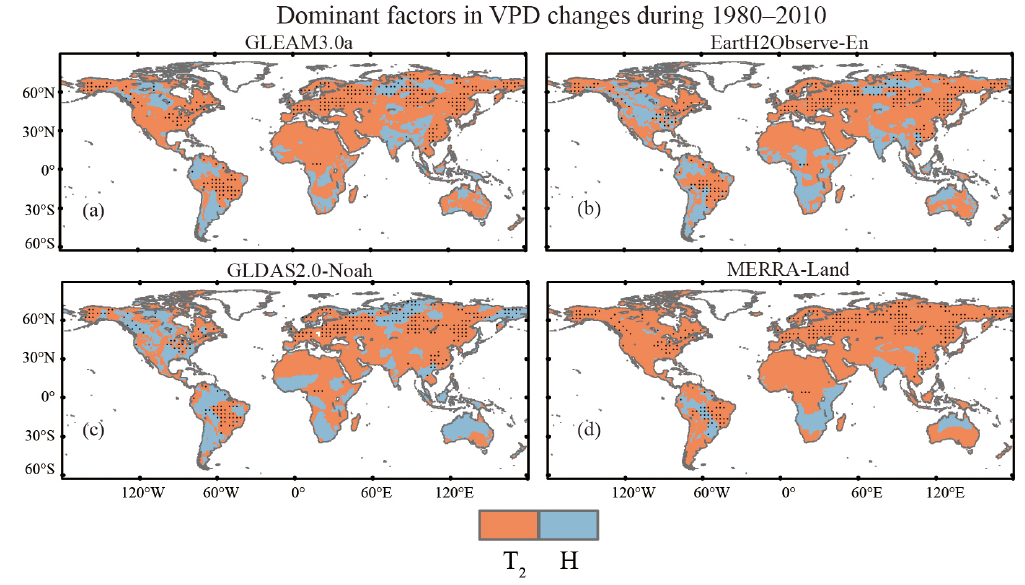
Figure 5. Distribution of dominant factor in VPD changes in global land during 1980–2010 for GLEAM3.0a (a) , EartH2Observe-En (b) , GLDAS2.0-Noah (c) , and MERRA-Land (d) . The T 2 and H represent air temperature and specific humidity respectively. Dotted areas mean that VPD is a dominant factor to ET